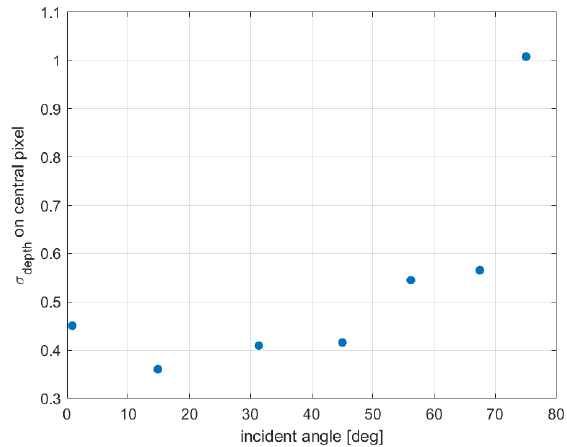
Figure 11. Standard deviation of the depth measurements on the center of the depth sensor varying the value of the incident angle.